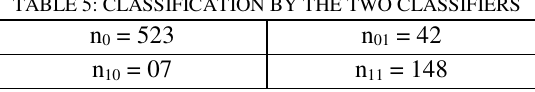
TABLE 5: CLASSIFICATION BY THE TWO